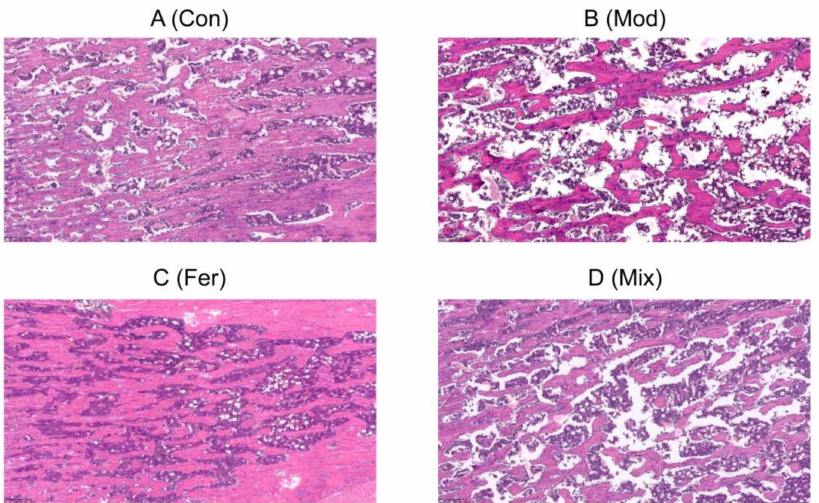
Figure 3. FS repaired the impairment of bone microarchitecture in osteoporotic rats. Representative pathological sections of the Con group ( A ), Mod group ( B ), Fer group ( C ) and Mix group ( D ). The Con, Mod, Fer, and Mix groups’ right tibias were sampled and prepared for paraffin sectioning, H&E staining, and bone microarchitecture.